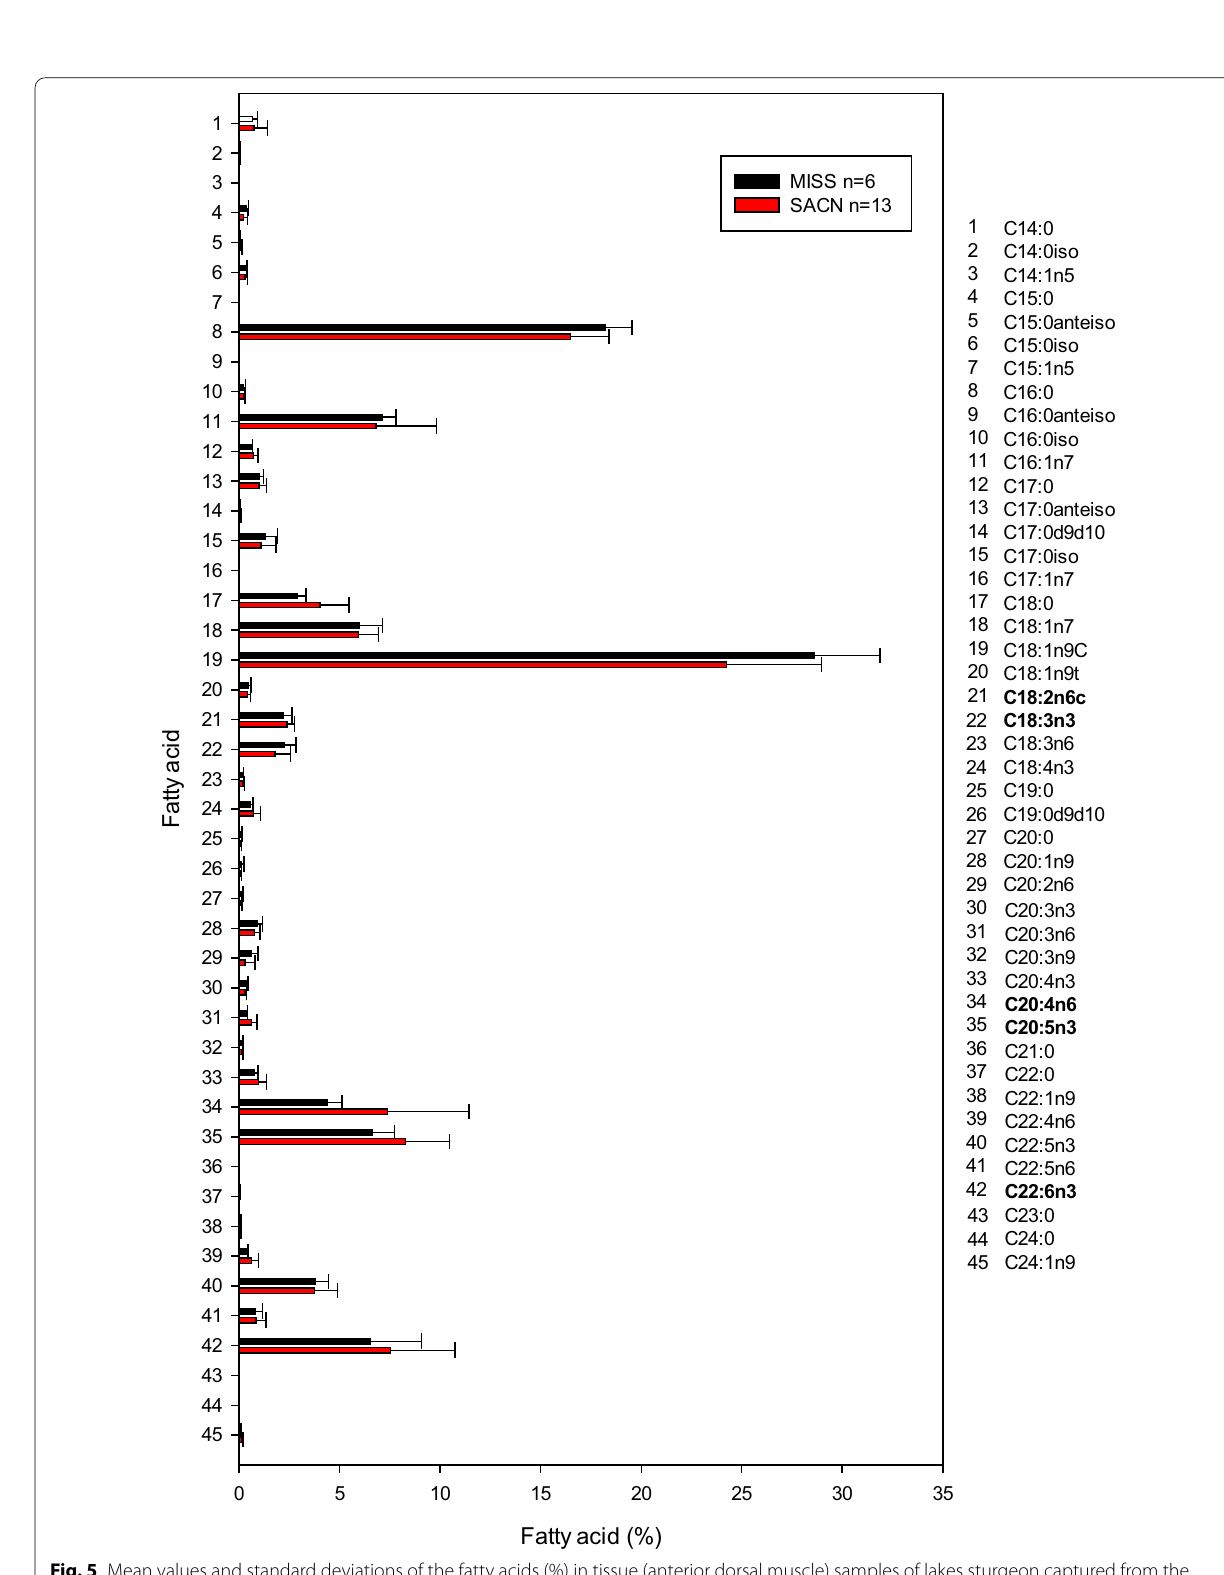
Fig. 5 Mean values and standard deviations of the fatty acids (%) in tissue (anterior dorsal muscle) samples of lakes sturgeon captured from the Mississippi (MISS) and St. Croix (SACN) Rivers. The essential fatty acids are indicated in bold text and include: LIN (C18:2n6c), ALA (C18:3n3),